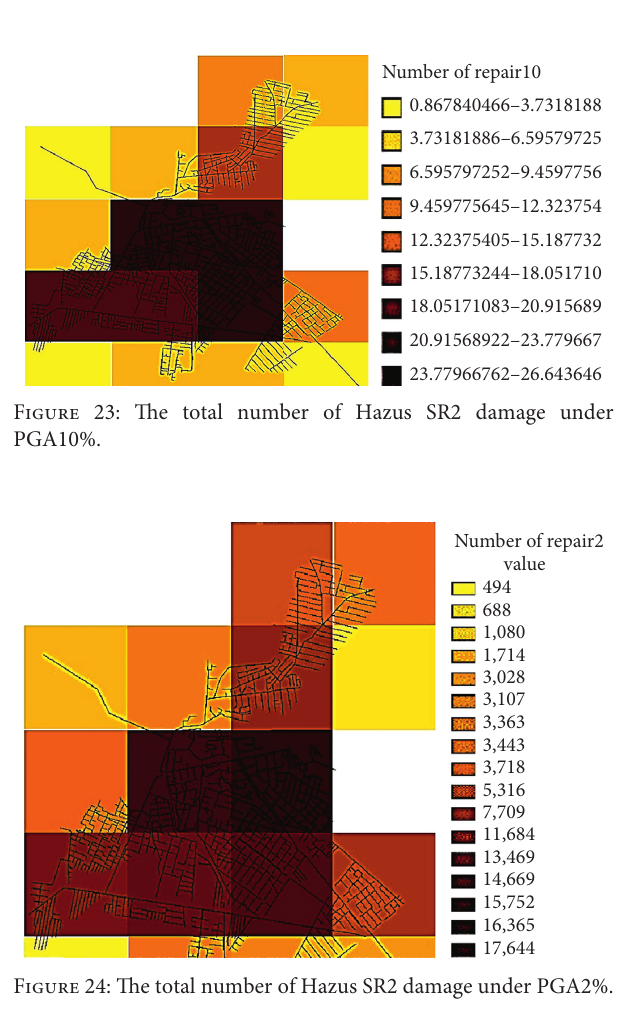
Figure 22: The PGA2 map and wastewater system.